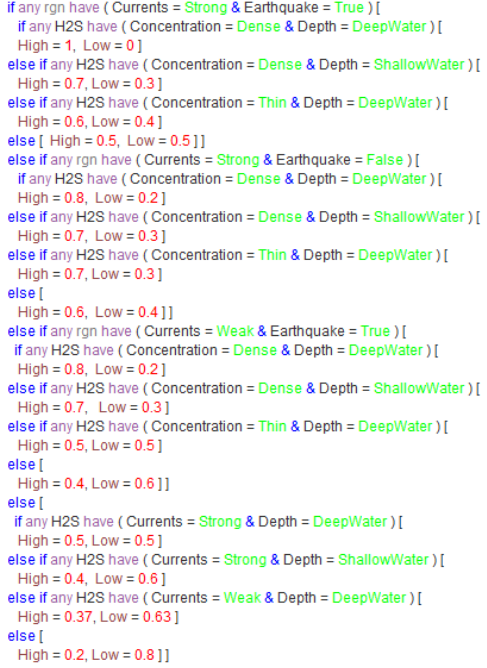
Figure 11. The joint probability distribution of emergency level.